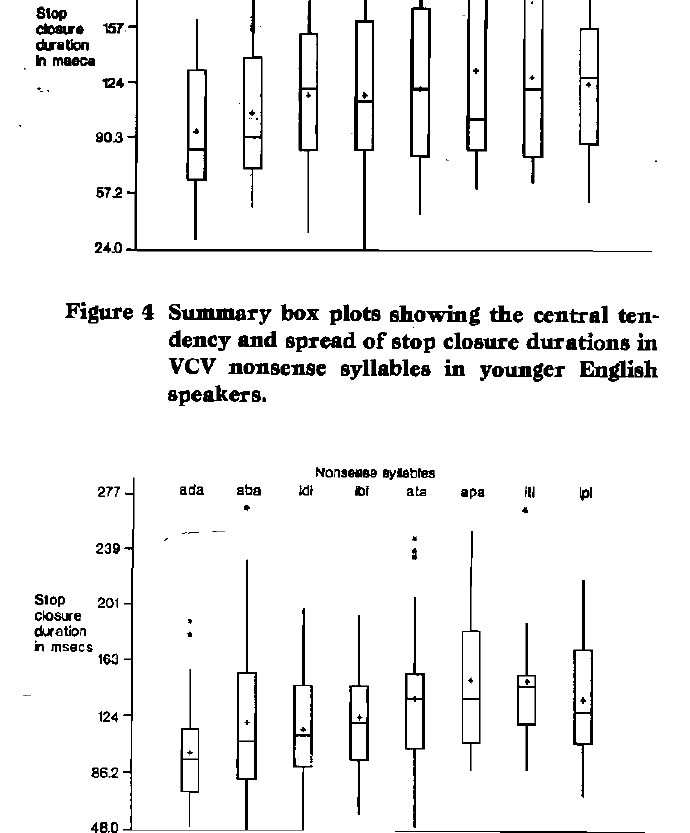
Figure 3 Summary box plots showing the central ten- dency and spread of stop closure durations in the VCV syllables in older Afrikaans speakers.